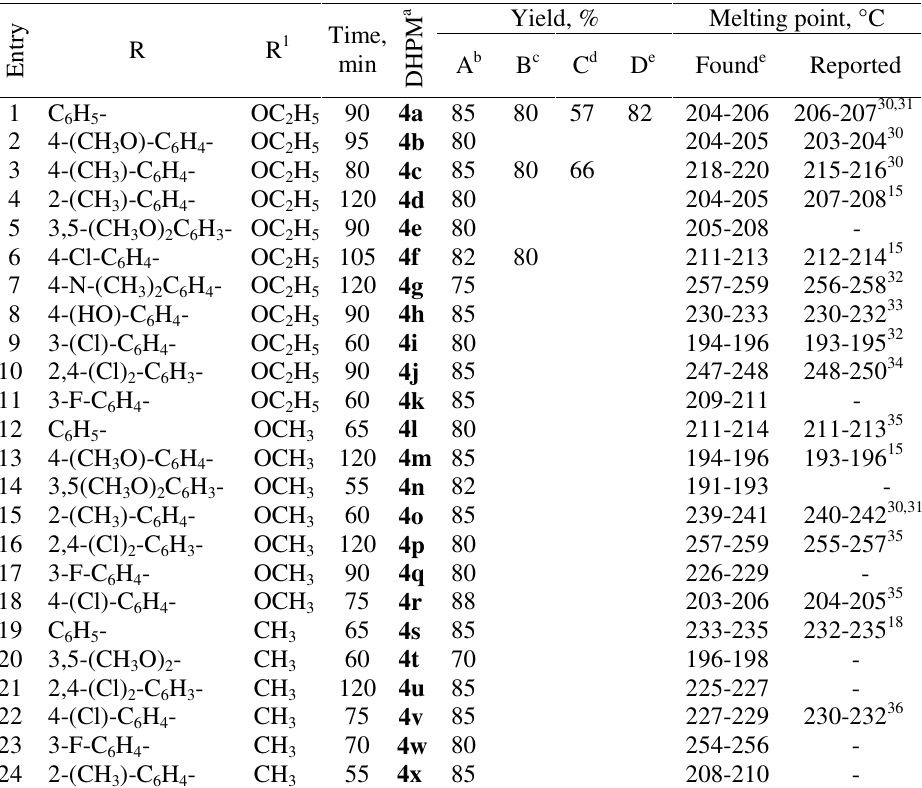
O-catalyzed synthesis of dihydropyrimidinones under solvent free 2